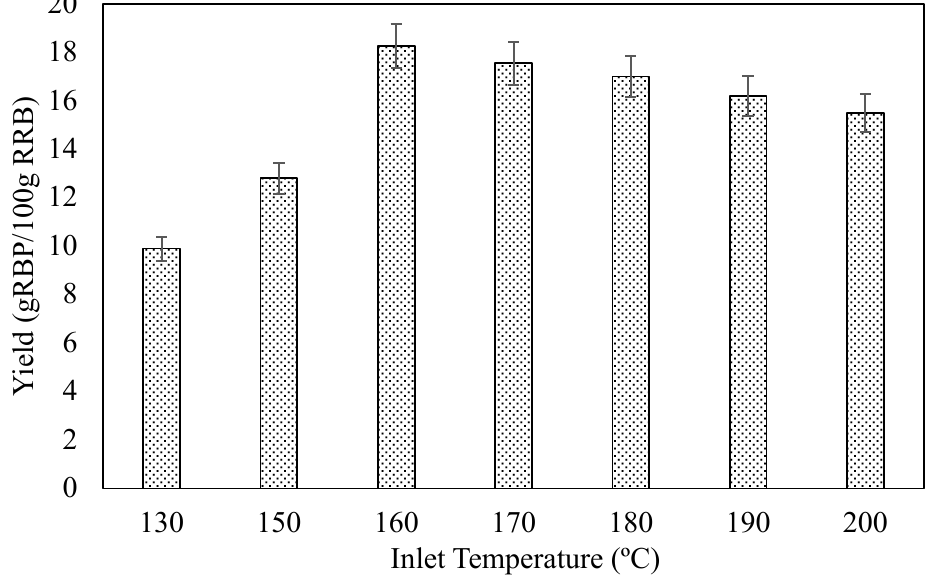
Figure 1. Effect of inlet temperature in spray-drying process on RBP powder yield at a constant feed flowrate of 20% and air flowrate of 388 L/h.